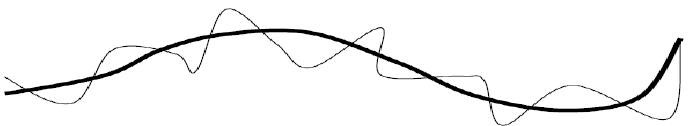
Figure 1. The geodesic as solution of the ODE. With noise, the geodesic is transformed in a more complex structure related to the Fisher information. The total effect is the percolation random geodesic.